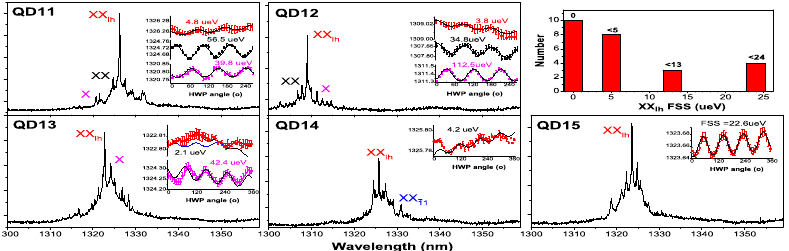
Figure 5. µ PL spectra of QD11–15 with dominant XX lh in various FSS. QD13–15 with charge field to vary FSS oscillation phase and show phonon-related spectral shoulder. QD14 in similar spectrum as QD9. ( Top-right ): statistics on XX lh FSS as measured.